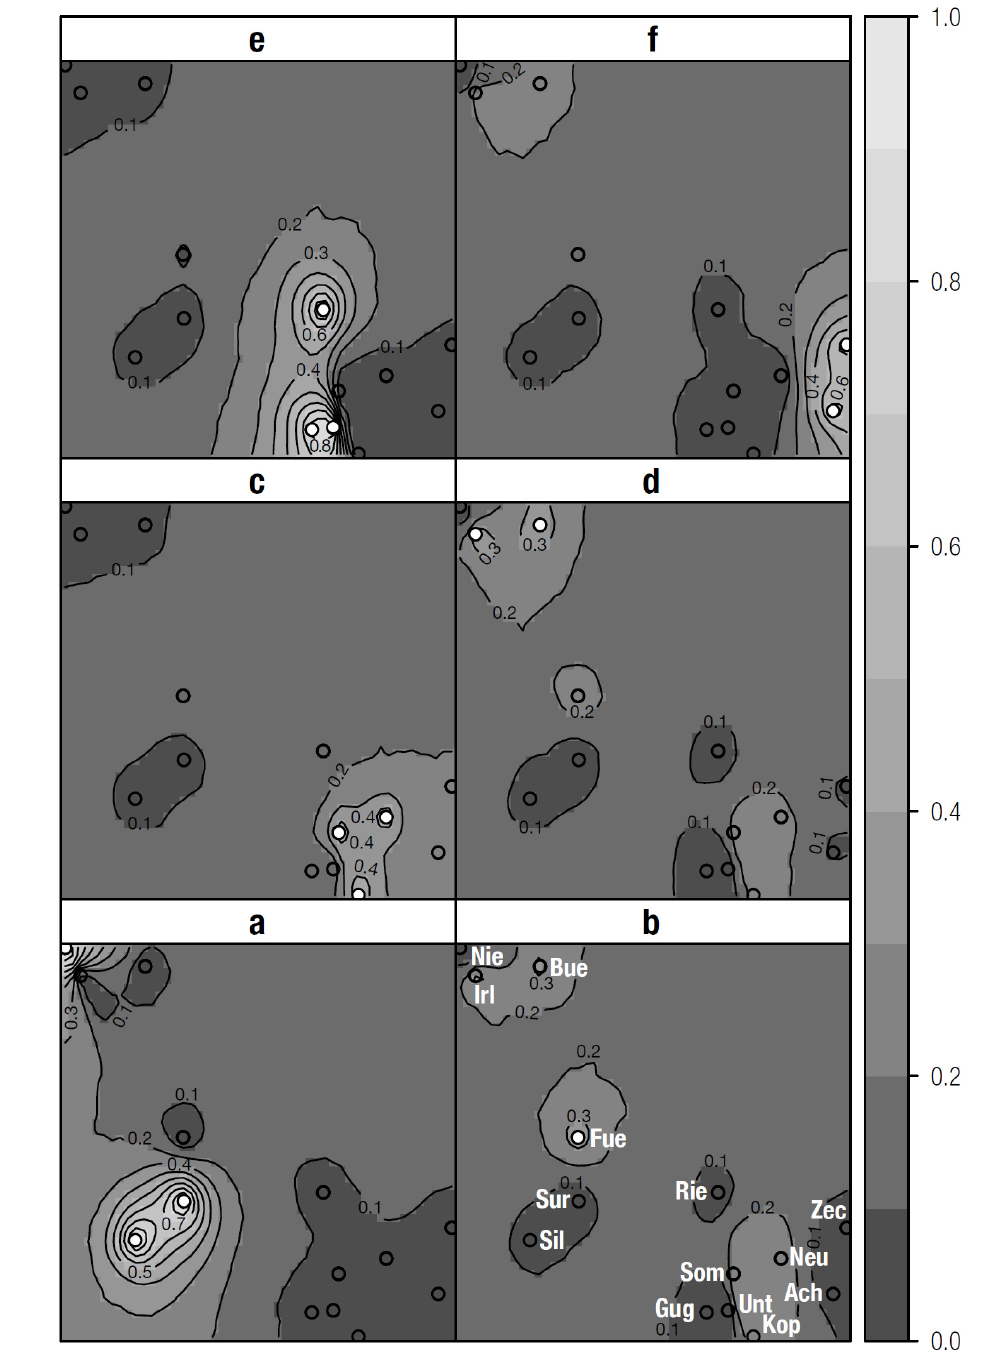
Figure 3. Maps of posterior probabilities for clusters 1-6 ( i.e. , a-f) obtained by analysis with